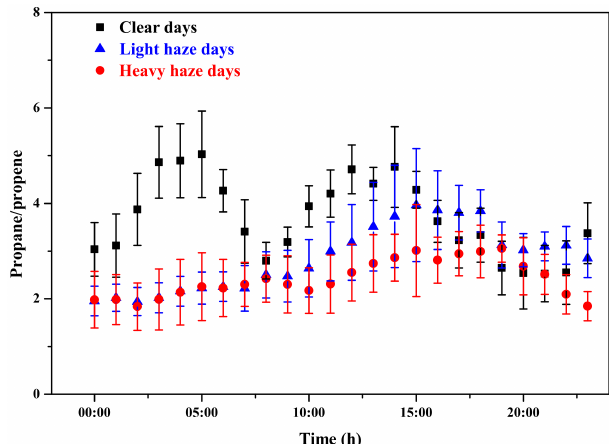
Figure 3. Diurnal variations in propane / propene ratios during clear days, light haze days, and heavy haze